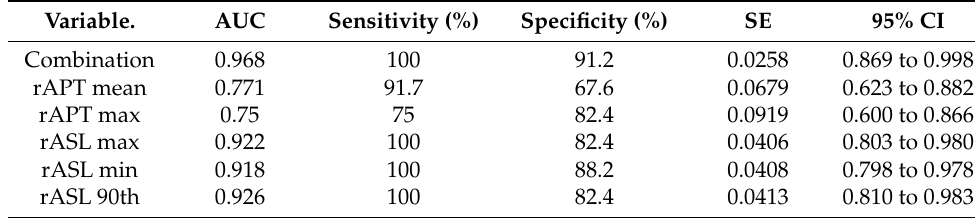
Table 5. ROC curve analyses of the selected parameters.